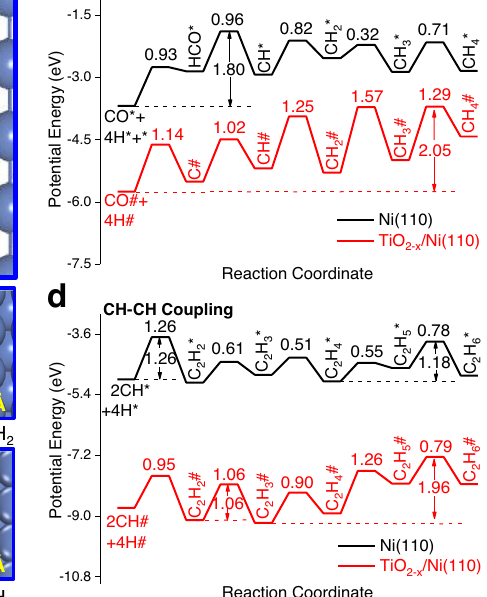
The blue, light gray, gray, red and white spheres are Ni, Ti, C, O and H atoms, respectively. c , d Potential energy diagrams for CO methanation and C 2 H 6 forma- tion via CH-CH coupling and hydrogenation over Ni(110) and Ti 6 O 11 /Ni(110) sur- faces, respectively. The elementary reactionbarriersare indicated in eV and all the energiesin( c )and ( d )arecalculatedwithrespecttoCO+2H 2 and2CO+3H 2 inthe gas phase,